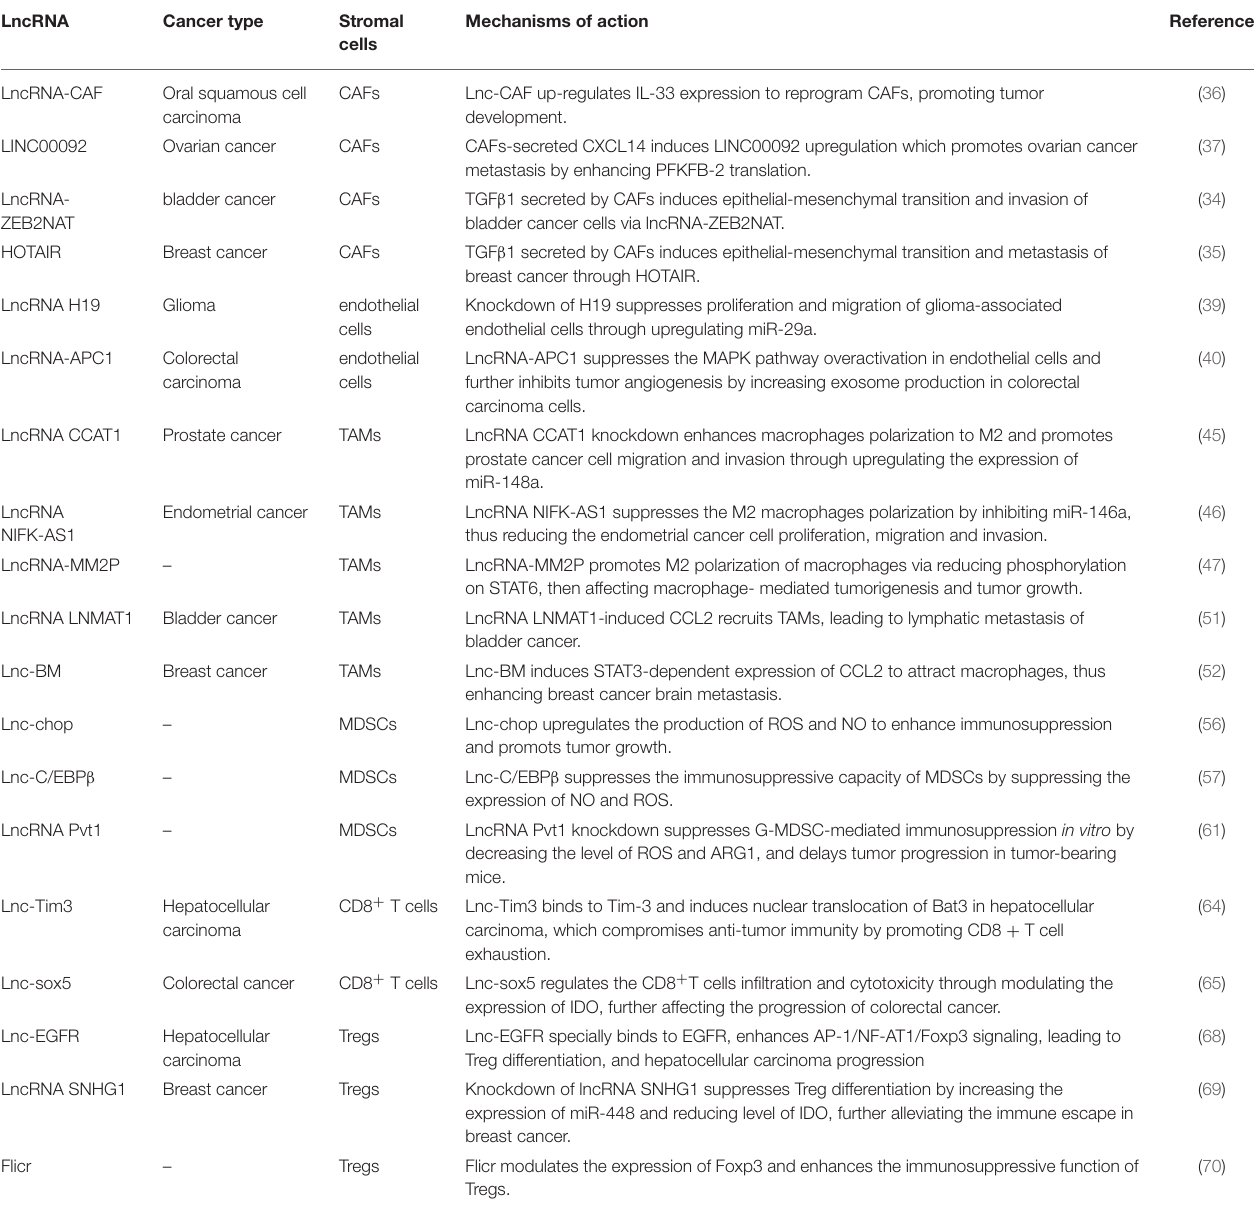
TABLE 1 | LncRNAs involved in the crosstalk between stromal cells and tumor cells.